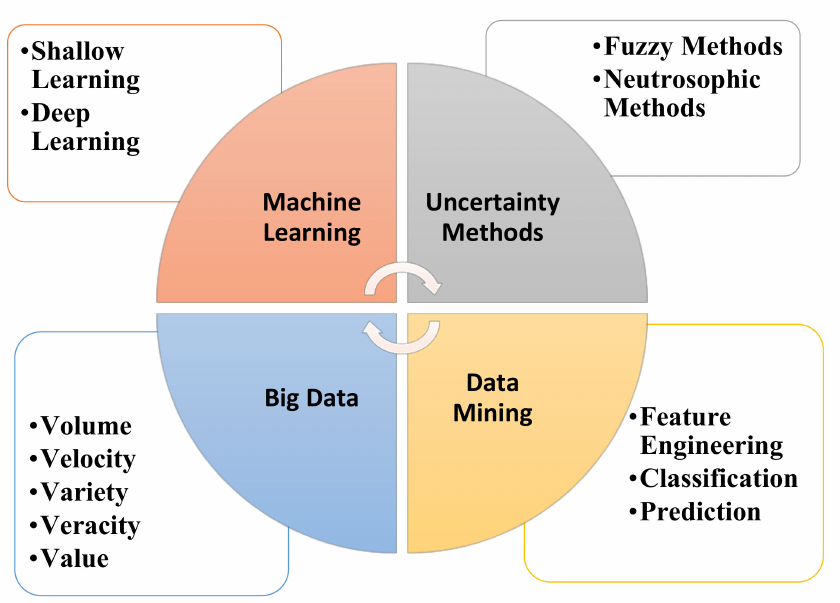
Figure 1. Diabetes and recent